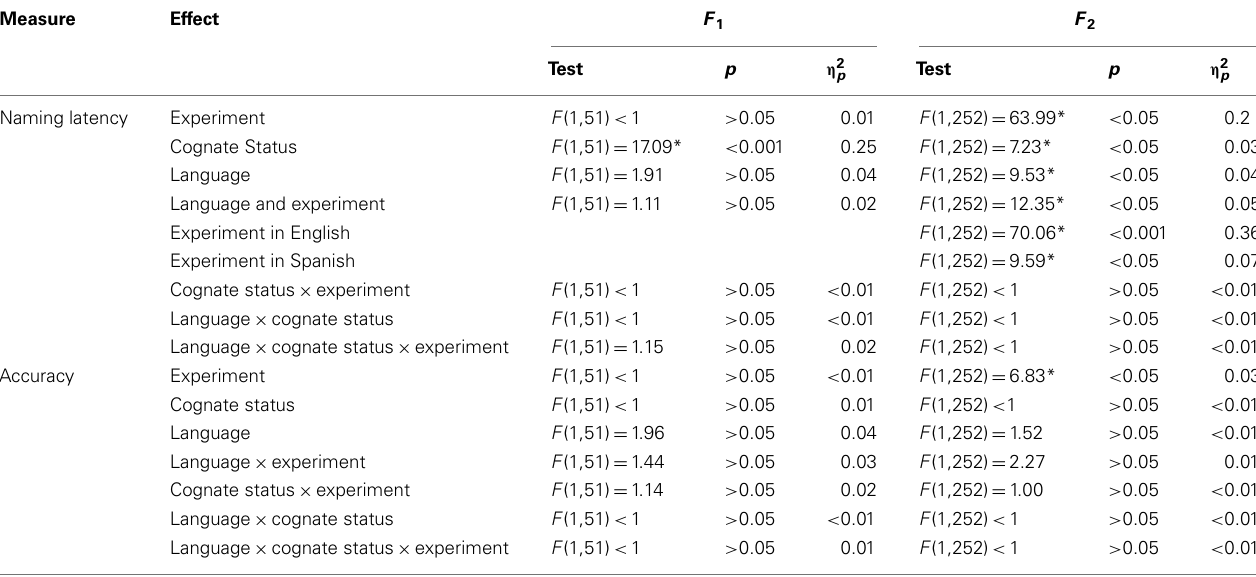
Table 7 | Mixed and blocked